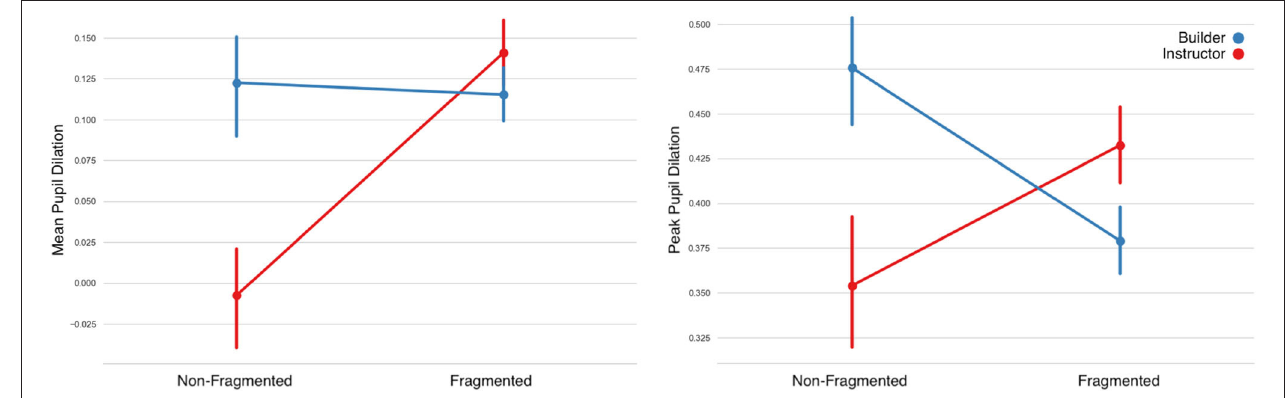
FIGURE 7 | Changes in pupil diameter during the Instructor’s utterances separated by Non-Fragmented/Fragmented Instruction class. Instructors’ cognitive load appears to be higher in constructing fragmented instructions overall, while the opposite effect is found for builders. Error bars indicate standard error of the means.